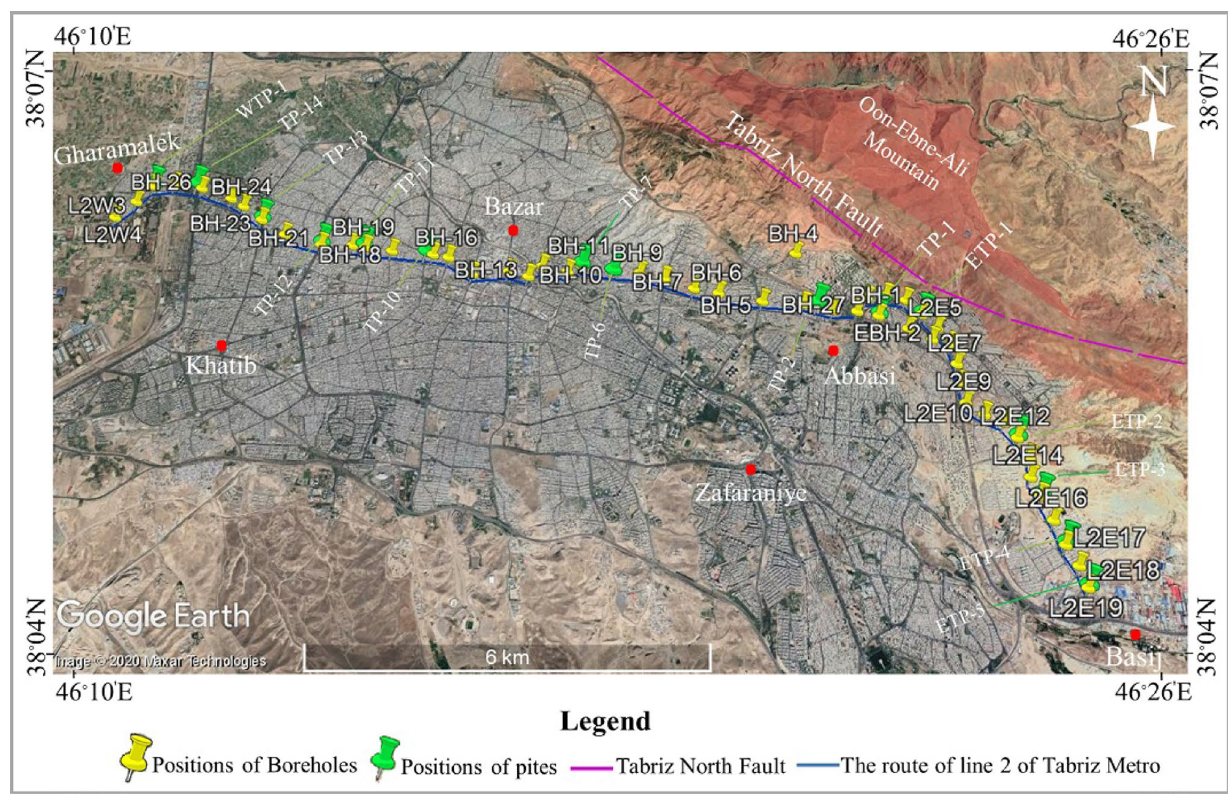
Fig. 1 Position of drilled pits and boreholes at the stations of Line 2 of Tabriz metro on satellite image (Authors)